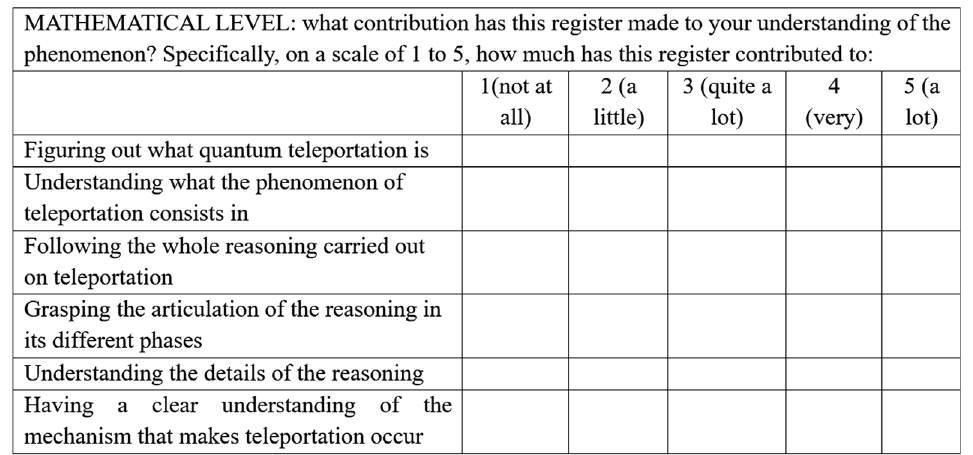
FIG. 31. About the narrative